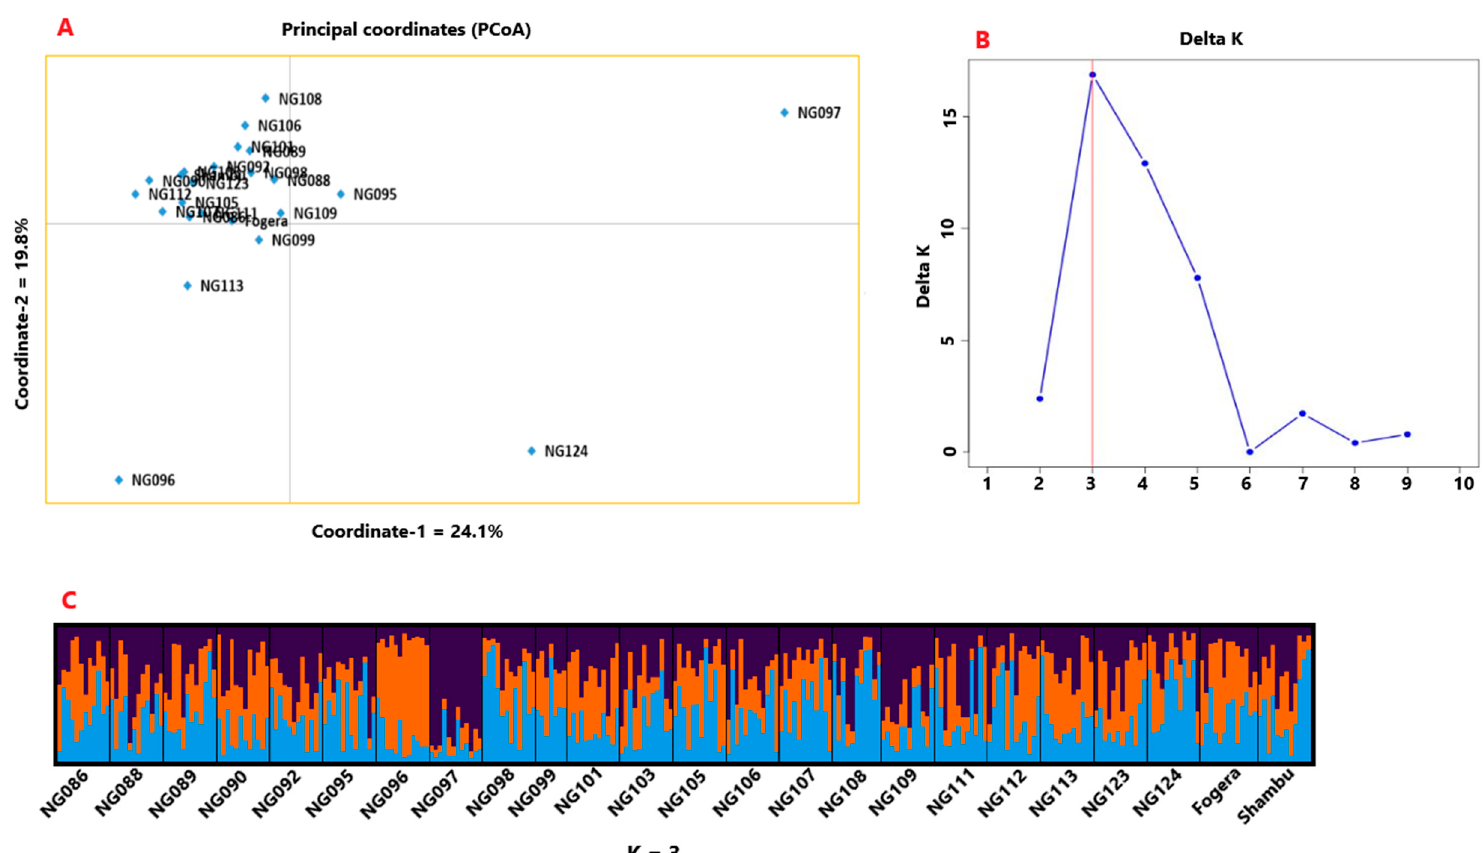
Figure 5. ( A ) Principal coordinate analysis (PCoA) based two-dimensional plot for the 24 accessions, in which the first and the second axes explained 24% and 20% of the total variation, respectively, ( B ) Δ K plot showing its maximum value at K = 3 suggesting the optimal number of genetic clusters (populations) of three, and ( C ) graphical representation of the population genetic structure of the 24 accessions for K = 3. The three colors represent the three clusters and the proportion of each color in each accession represents the average proportion of the alleles that placed each accession under the three clusters.